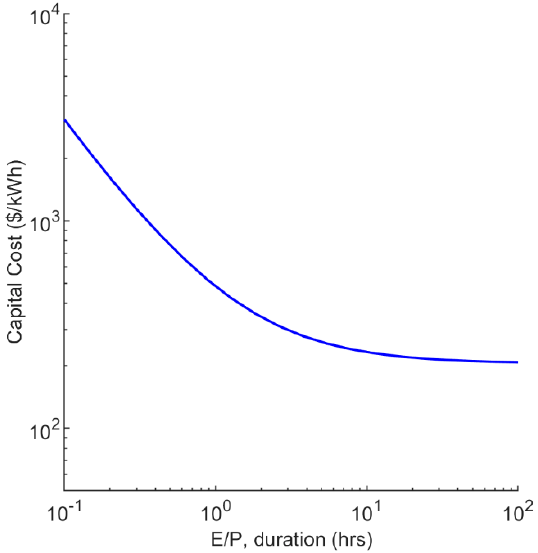
Figure 2. Graph of inverse-exponential relationship between VRFB module capital costs with respect to the energy over power ratio (E/P). The energy storage costs of VRFBs are less the fixed cost of LIBs (USD 285/kWh) when the E/P ratio is greater than 3.4 h.